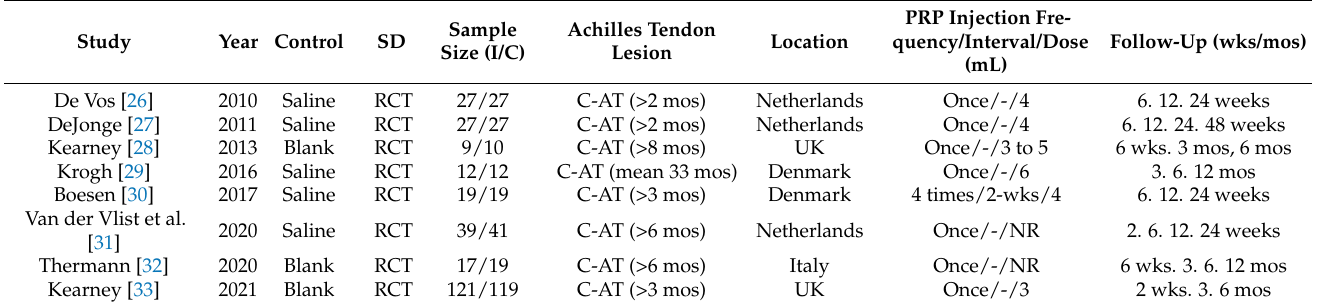
Table 1. Characteristics of the included studies.